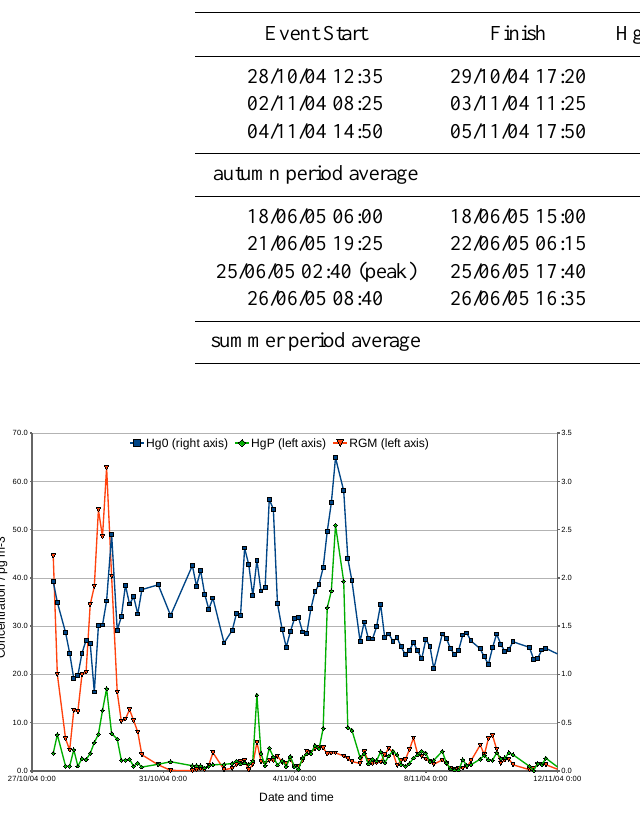
Fig. 3. The measured atmospheric Hg species concentrations during the autumn 2005 oceanographic